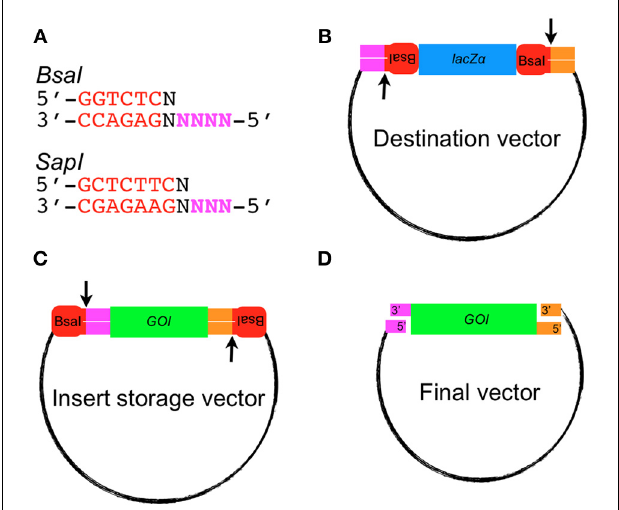
FIGURE 1 | Golden Gate assembly of an insert into the destination vector. (A) Recognition sequences for the Type IIS restriction endonucleases BsaI and SapI . 5 (cid:2) overhang sequences used for annealing fragments are shown in bold magenta lettering. (B) Example of a Golden Gate-compatible destination vector. Note the orientation of the BsaI sites cause excision of the lacZ α gene. (C) Example of a Golden Gate compatible vector containing a gene of interest (GOI) that will be released after digestion with BsaI . (D) A typical Golden Gate Cloning reaction would involve mixing the destination vector and insert storage vector together into one tube at equal molar ratio with BsaI and T4 DNA ligase. The final vector produced would lack BsaI recognition sequences and be resistant to digestion.